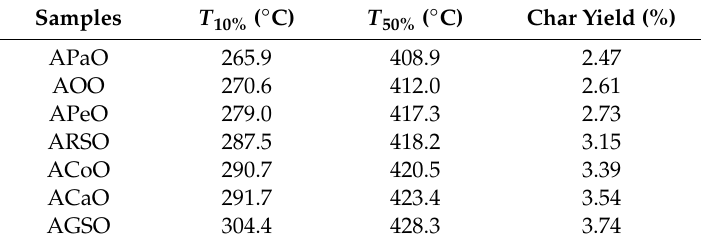
Table 3. Thermal stability of the UV-cured films.